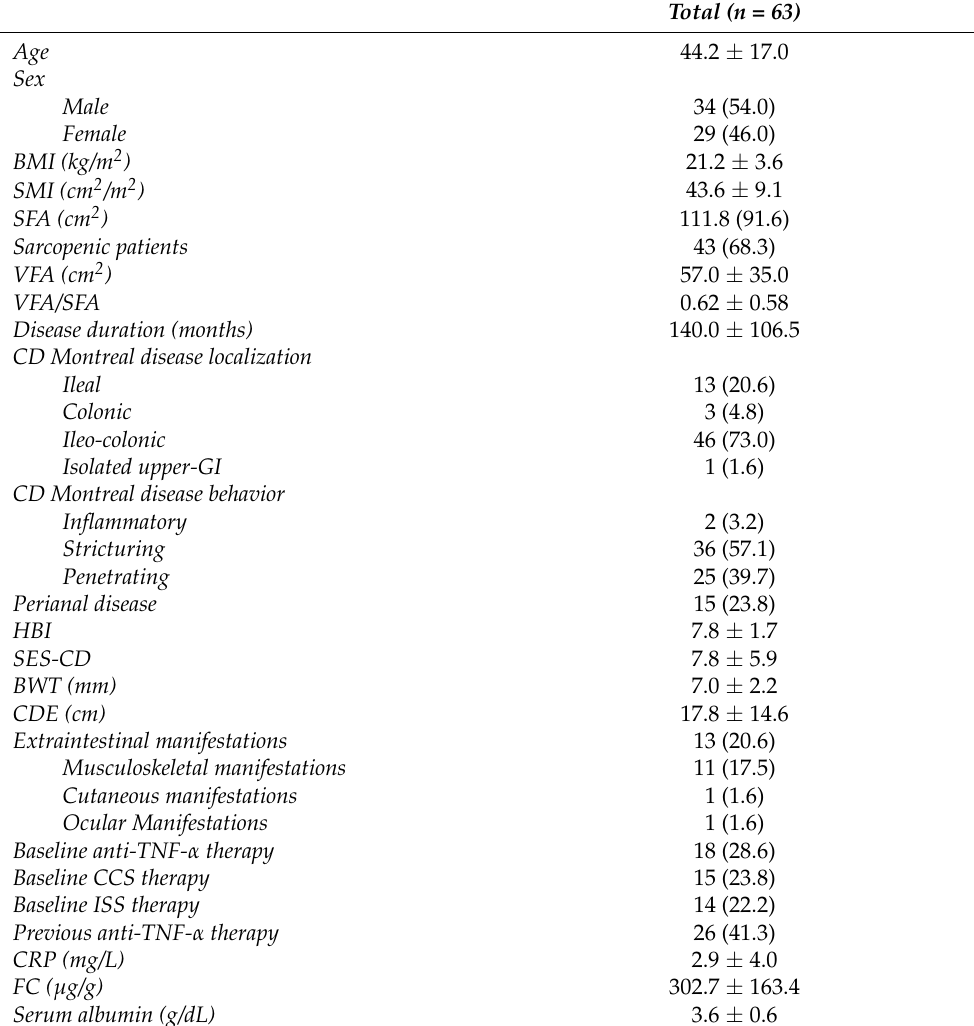
Table 1. Baseline demographic characteristics of